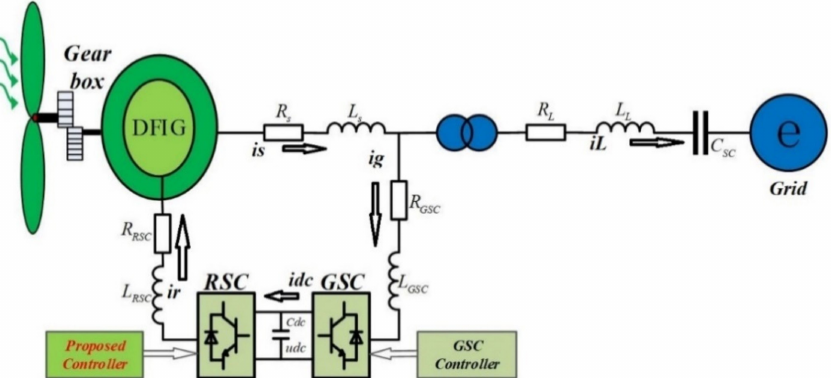
Figure 1. Structure of series-compensated doubly fed induction generator (DFIG)-based wind farm connected to